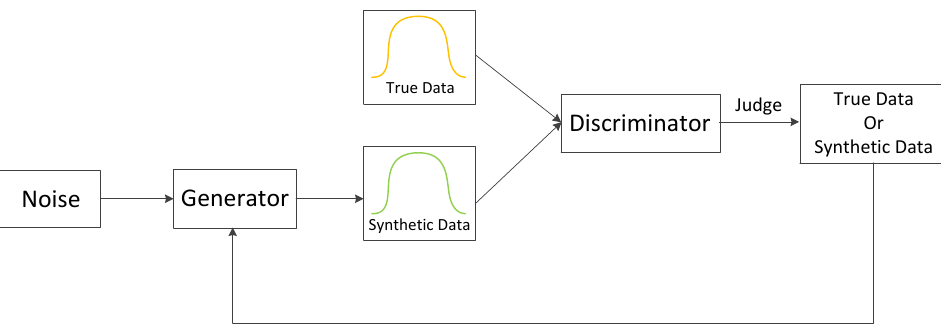
Figure 1. Schematic diagram of the